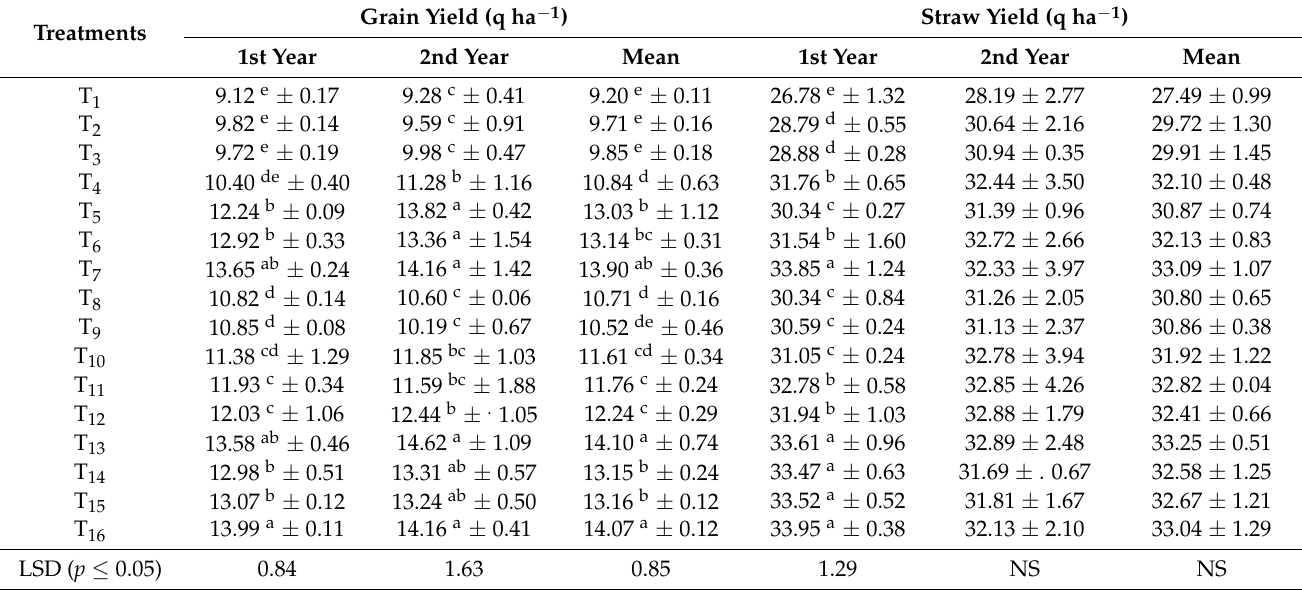
Table 2. Effect of mineral, chelated and nanoforms of Zn and Fe on grain and straw yield of chickpeas. Treatments